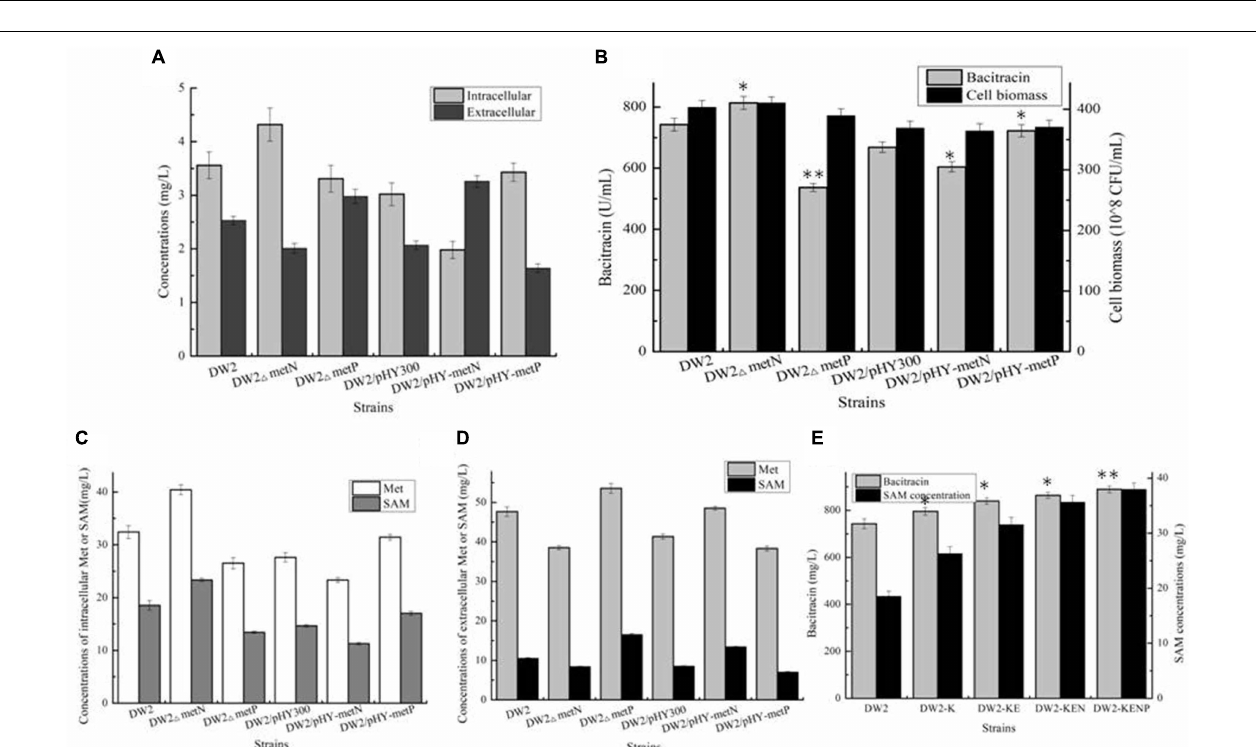
overexpressed in DW2, attaining DW2 (cid:77) metN, DW2 (cid:77) metP, DW2/pHY-MetN and DW2/pHY-MetP, respectively. Then, these strains were cultivated in ME medium, and the concentrations of intracellular and extracellular Met were measured after 24